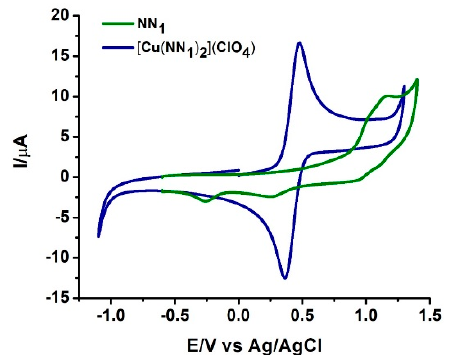
Figure 4. Characteristic cyclic voltammograms for ligand NN 1 (green) and coordination complex [Cu(NN 1 ) 2 ](ClO 4 ) (blue). NN 1 and [Cu(NN 1 ) 2 ](ClO 4 ) in (CH 2 Cl 2 ) and 0.1 M TBAP. Potential are related to Ag/AgCl at 100 mV/S scan rate.